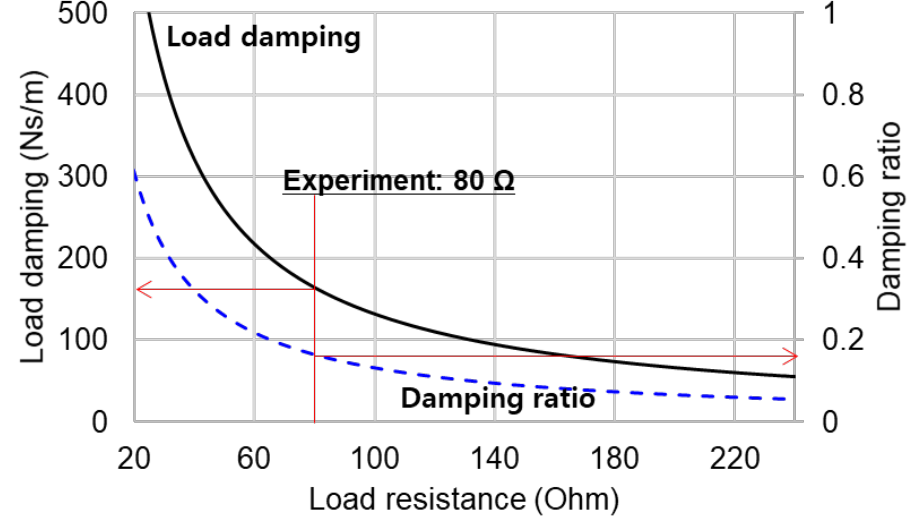
Figure 4. Prediction of the load damping coefficient and average damping ratio for cases 1–5 at increasing load increasing load resistances.